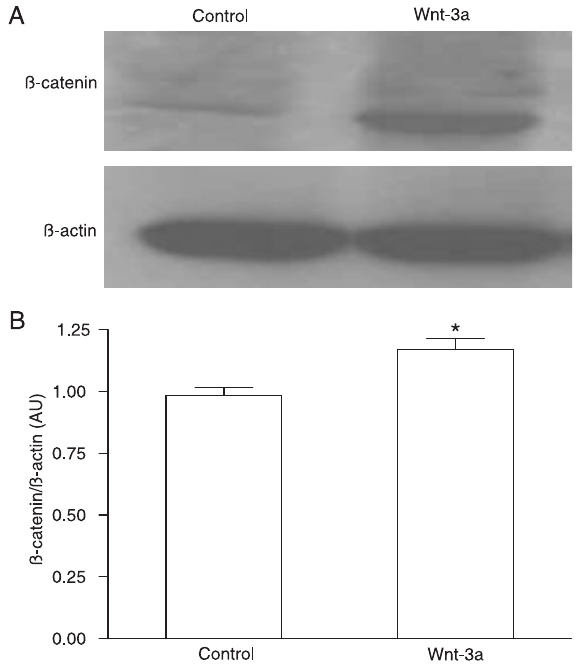
Figure 2. Effects of Wnt-3a (100 ng/mL) on β-catenin expression by immunoblot assay. A , A representative immunoblot shows in- creased β-catenin expression in PC12 cells incubated with Wnt- 3a recombinant peptide. β-actin was used as internal control. B , The respective densitometric analyses (arbitrary units, AU) of the β-catenin/β-actin ratio bands presented in Panel A is shown. Data are reported as means ± SEM for 5 independent experiments. *P < 0.02 compared to control (unpaired Student t